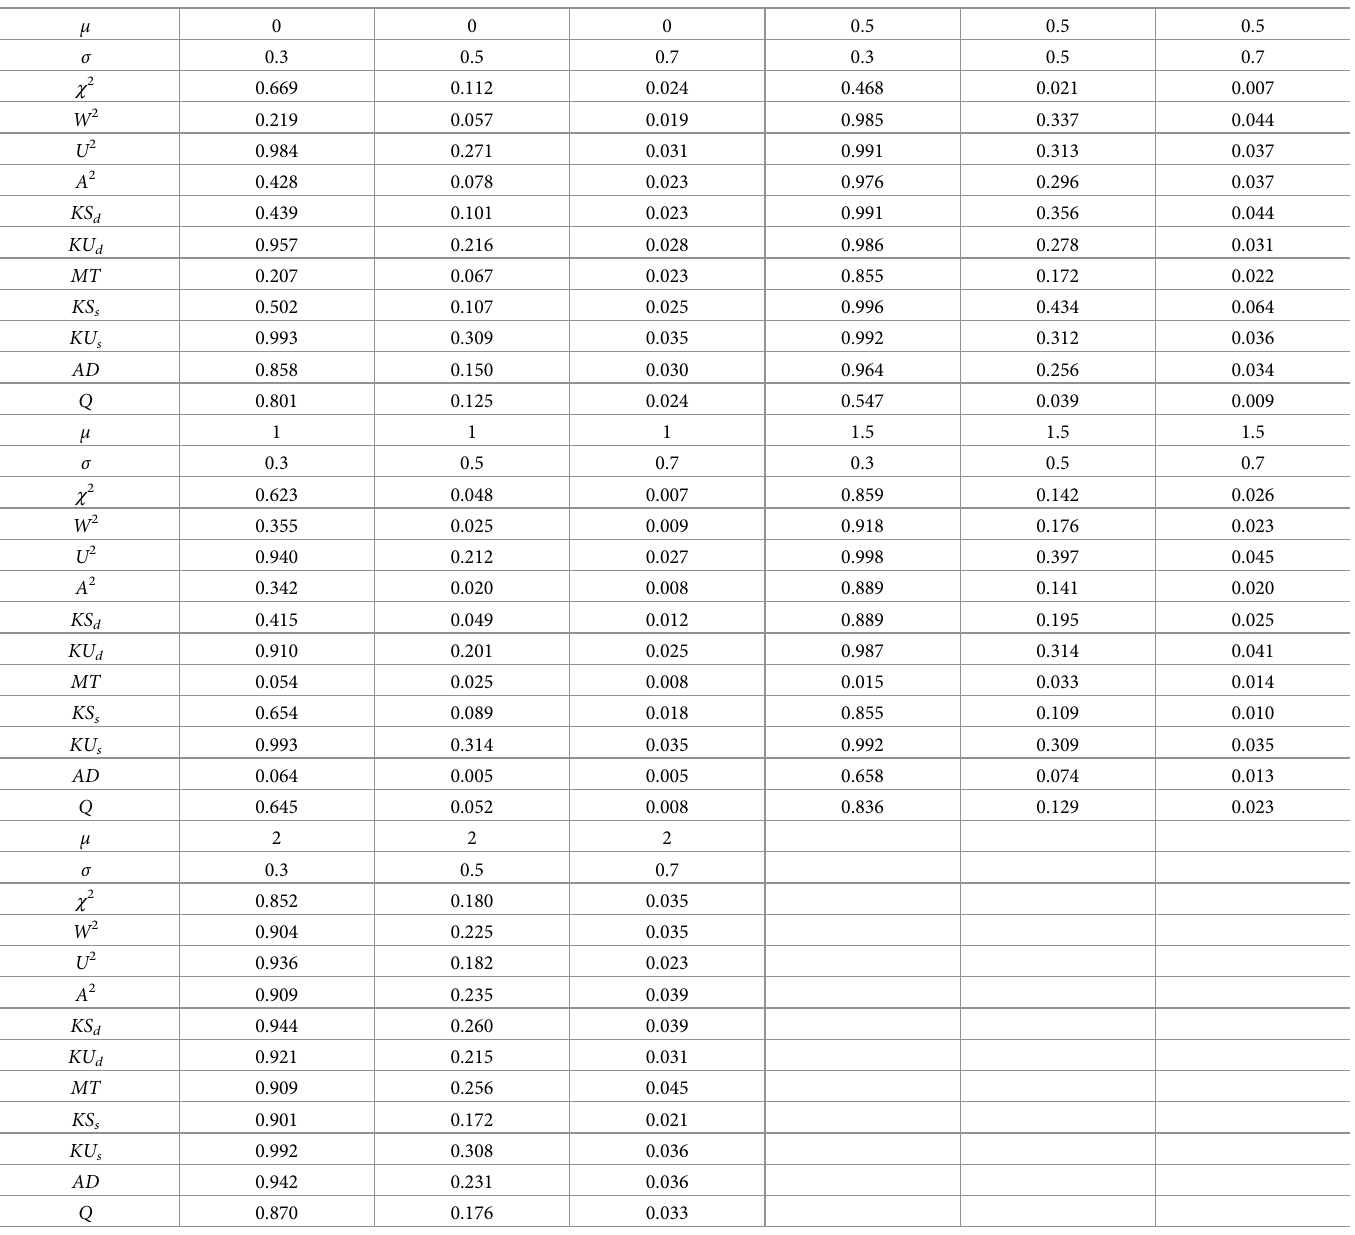
Table 4. Rejection rates for Lognormal distributed